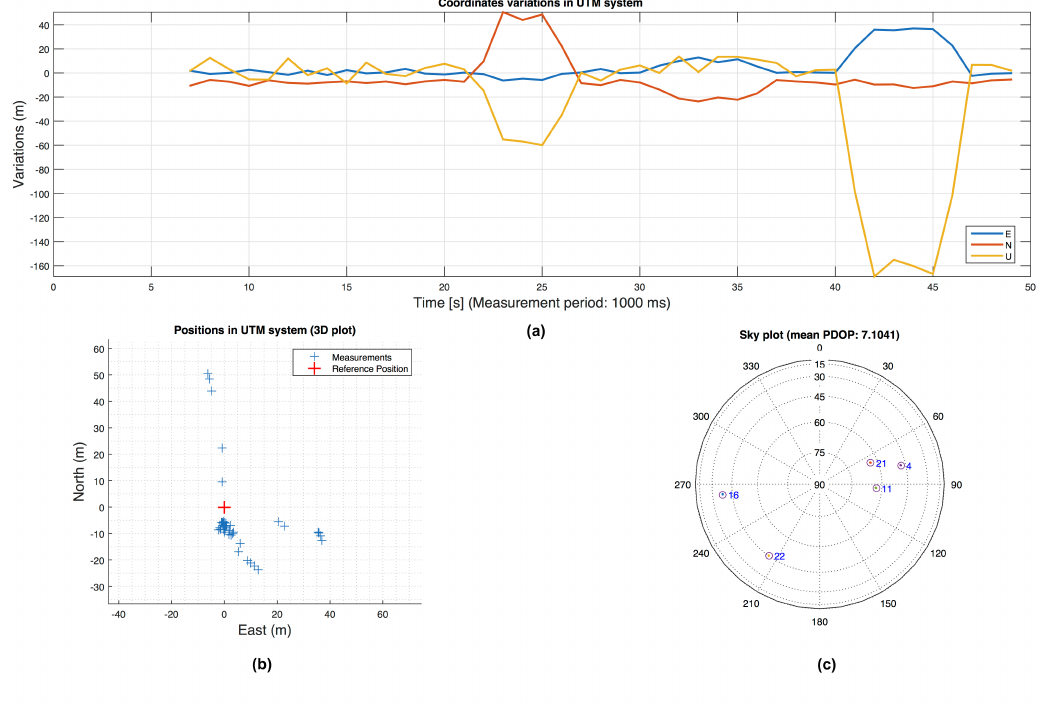
Figure 11. WLS solution of the scenario 1. In ( a ) the position error is shown. The East-North coordinates ( b ) and the skyplot ( c ).